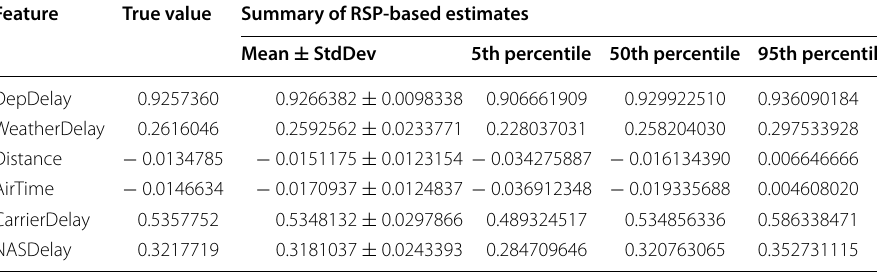
RSP-based coefficients were calculated from a sample of RSP blocks ( g = 10 )